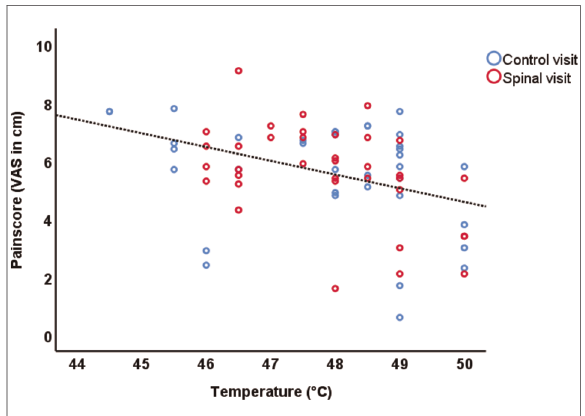
FIGURE 2 Scatterplot of the VAS scores and temperature of the control session and spinal anesthesia session.